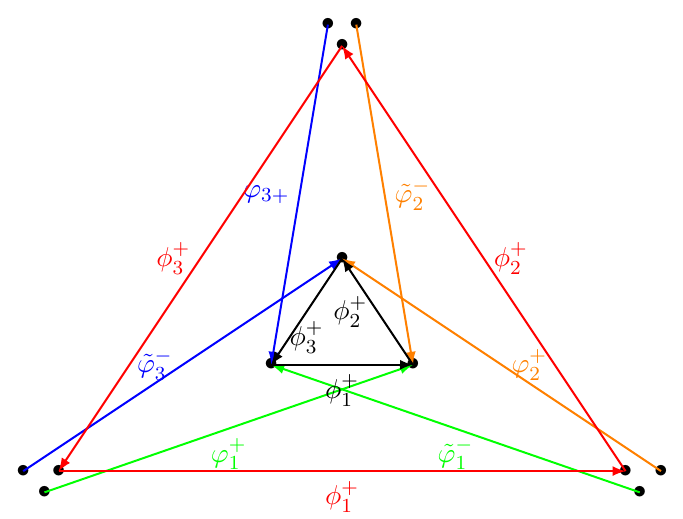
Figure 5. Parallel branes C [ (cid:22) R ] and C [ (cid:22) L ], with C [ (cid:22) L ] being the outer brane. We only indicate the polarization for the outermost brane by two additional (cid:15) next to each extremal weight state. The maximal intra-brane Higgs are denoted as (cid:30) + maximal regular inter-brane zero modes are labeled by ’ + sector